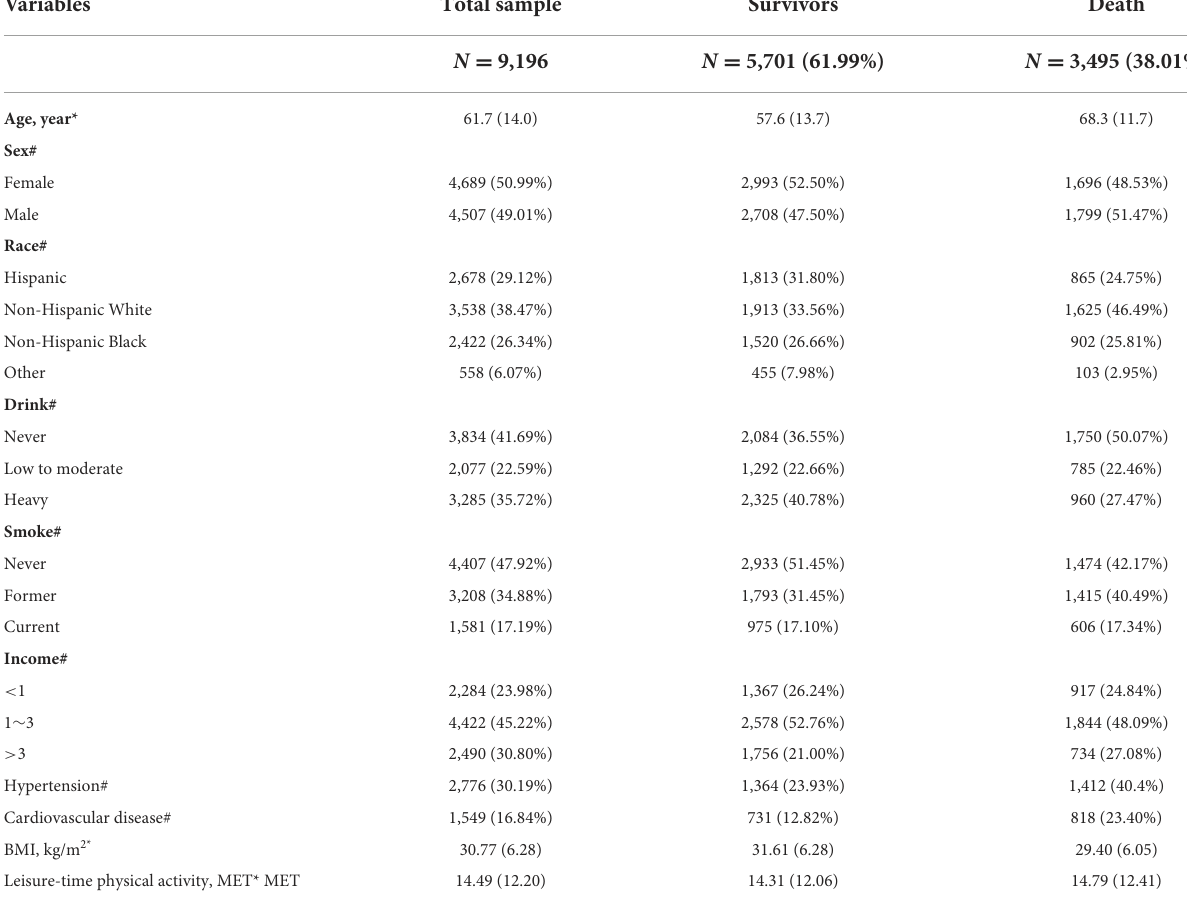
TABLE 1 Baseline characteristics of the study